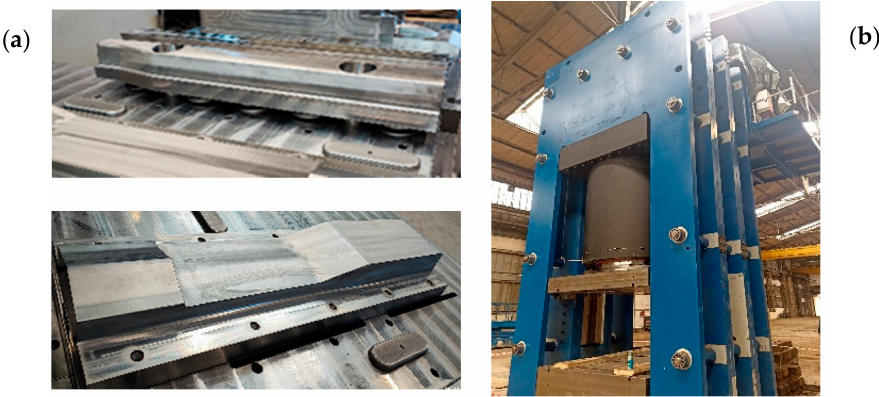
Figure 20. Photos of: ( a ) selected tools used to forge a 60E1A6 profile, ( b ) the hydraulic press of 5000 tons pressure.